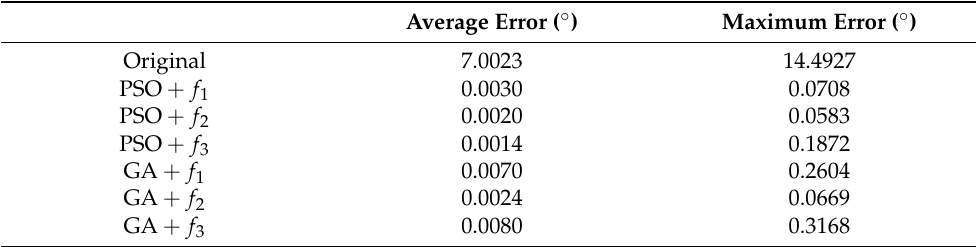
Figure 8. Comparison of the β prediction. ( a ) Histogram of the prediction error of β for the network optimized by the GA with f 1 . ( b ) Histogram of the prediction error of β for the network optimized by the GA with f 2 . ( c ) Histogram of the prediction error of β for the network optimized by the GA with f 3 . ( d ) Histogram of the prediction error of β for the network optimized by PSO with f 1 . ( e ) Histogram of the prediction error of β for the network optimized by PSO with f 2 . ( f ) Histogram of the prediction error of β for the network optimized by PSO with f 3 . ( g ) Histogram of the prediction error of β for the network without optimization. Table 3. Error comparison for the sideslip angle prediction.